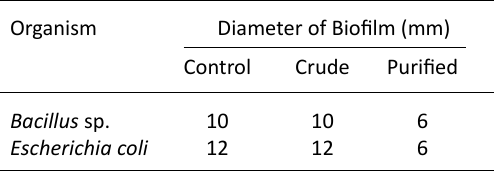
Table 2. Results of swarming motility assay